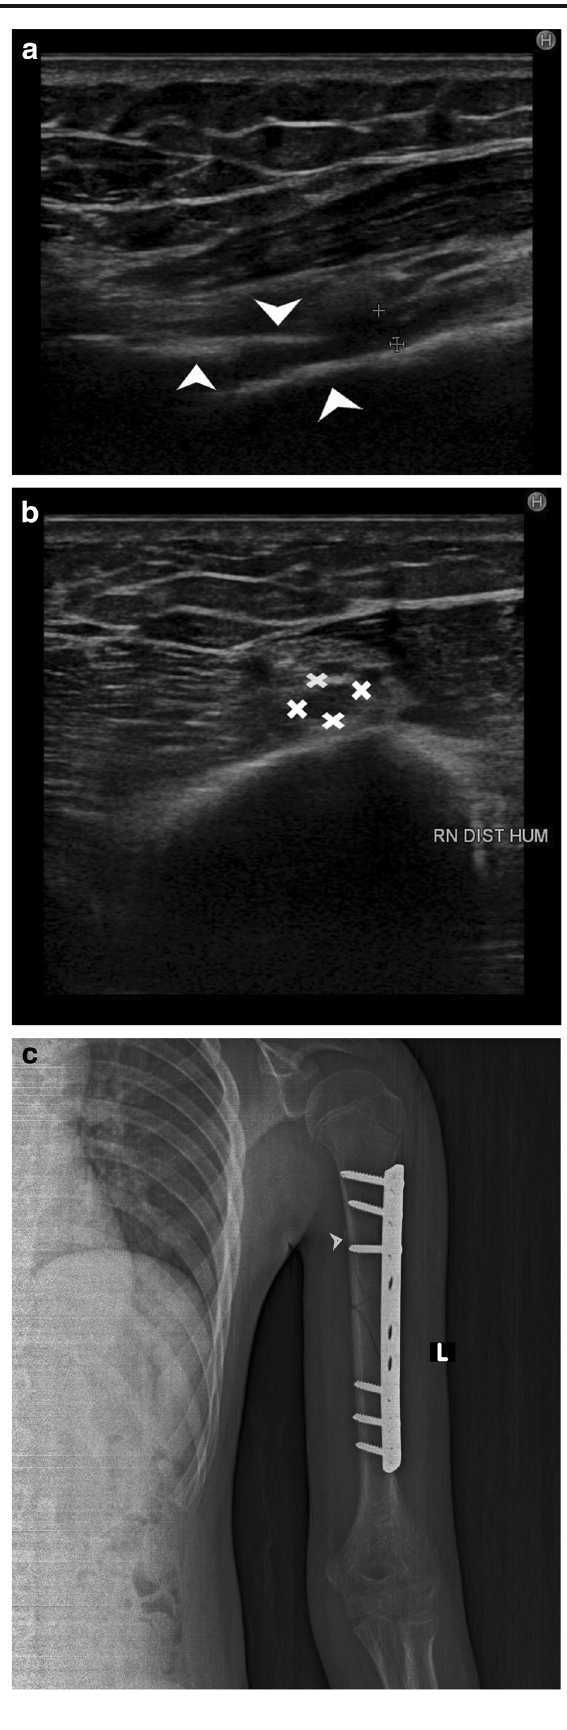
Fig. 3 a Hypoechoic radial nerve is seen in the longitudinal plane (between crossheads) entrapped between two edges of the fracture segment (arrowhead). b Hypoechoic radial nerve, crossheads, in its short axis just distal to the site of entrapment. c Plain radiograph after open reduction and internal fixation in a patient with fracture of the humerus shaft (arrowhead). The nerve was impinged within the fracture segment in the spiral